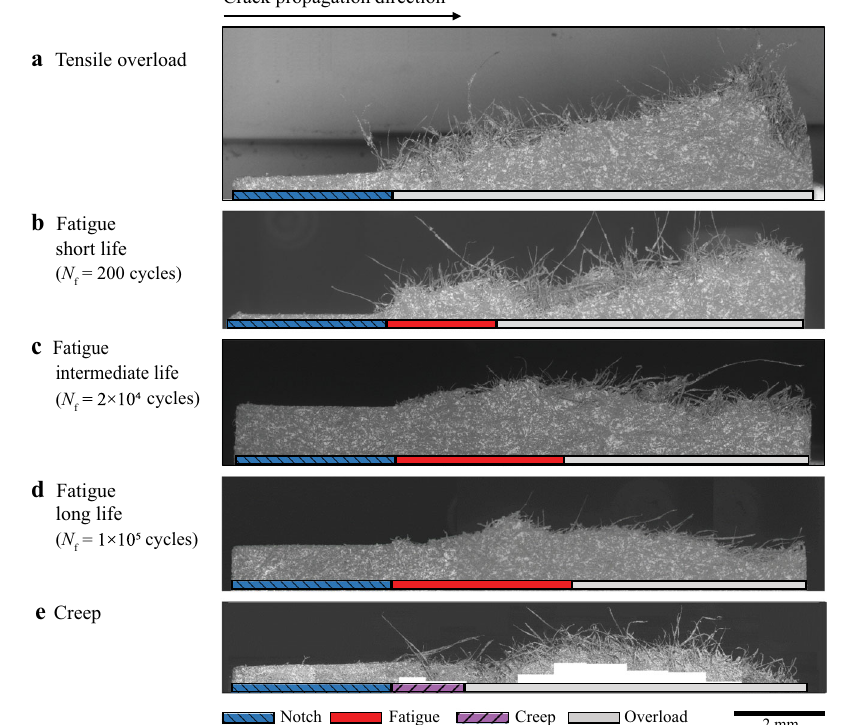
Fig. 3 Tensile overload, fatigue, and creep crack pro fi les. Scanning electron microscopy images of representative crack pro fi les the of notched paper specimens that failed during a tensile, b , c , and d fatigue, and e creep tests. The cracks grew completely across the specimen from the cut notch tip as indicated in the fi gure. Tensile overload and creep fractures are fi brous (hairy) because the inter fi ber bonds fail and fi bers pull out. In contrast, fatigue damage causes fi ber fracture and less fi brous crack pro fi les. The various parts of the crack path (notch, fatigue, creep, and overload) for each specimen were determined using digital image correlation and can be identi fi ed using the horizontal bar under each crack pro fi le and the legend.